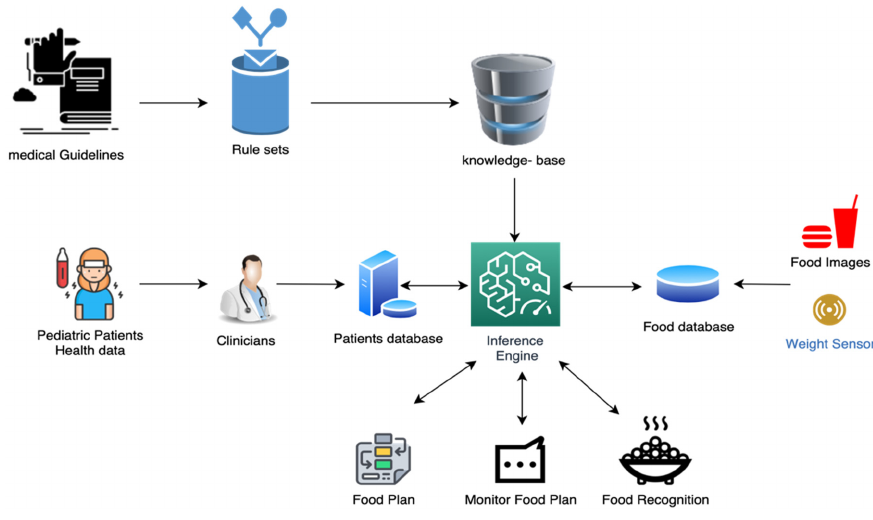
Figure 1. framework for the system. Figure 1. Framework for the